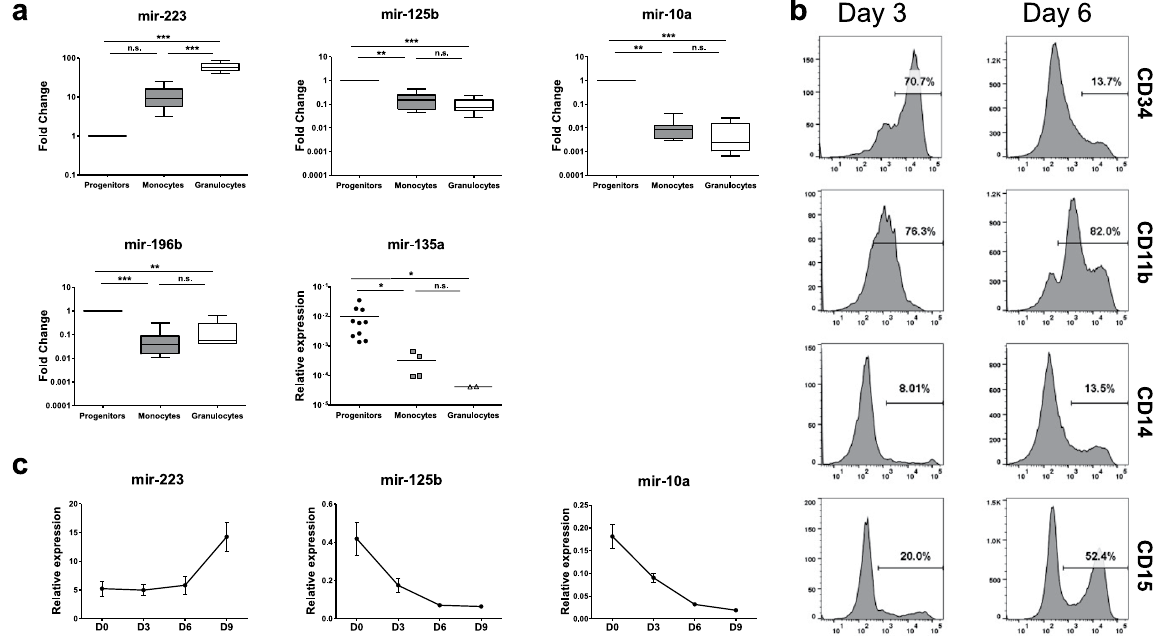
Figure 3. Decreased expression of miR-125b and miR-10a is associated with increased lineage commitment of myeloid progenitors. ( a ) qRT-PCR validation of miRNAs differentially expressed in TLDA experiments (n = 10). The small nucleolar RNA RNU24 was used for normalisation. Whiskers show 5th and 95th percentiles. miR-135a could not be amplified from most monocyte and neutrophil samples; the results have therefore been shown here as expression relative to RNU24 only. Differences were tested by ANOVA, Kruskal Wallis test with Dunn’s post test. *** p < 0.001, ** p < 0.01, * p < 0.05, n.s. = not significant. ( b ) Expression of CD34, CD11b, CD14 and CD15 on MACS-purified cord blood CD34 + cells cultured for 6 days with SCF (100 ng/mL) and GCSF (10 ng/mL). ( c ) The same cytokines were used to in vitro differentiate FACS-purified CD34 + cells and their levels of miR-223, miR-125b and miR-10a assessed by q-RT-PCR over nine days (n = 3). Graphs show mean ± SEM.